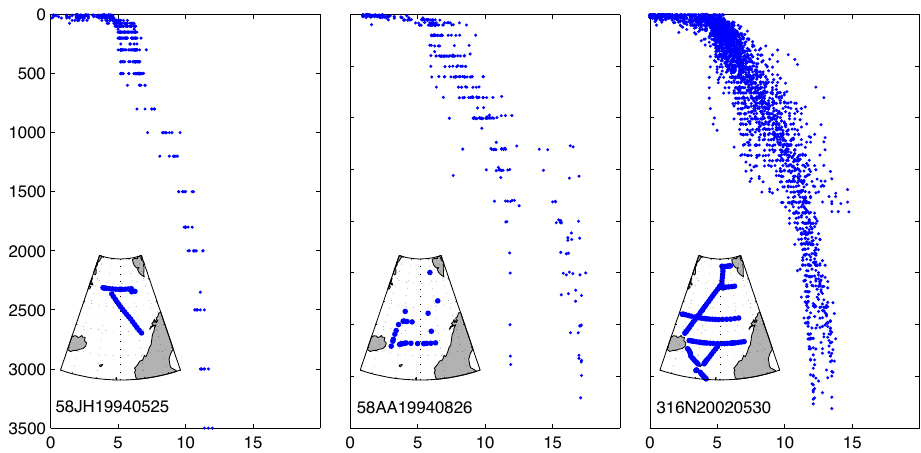
Figure 6. Silicate profiles from 58AA19940826 and two other cruises. the phosphate data of 58JH19920712 which appear low, this cruise took place over the Greenland Scotland Ridge area and can not be expected to be consistent with the others which were located mainly in the Greenland Sea and the Norwe- gian Sea, and has been labelled are “NC”. The greater hy- drographic variability in this region leads to di ffi culties in the evaluation of adjustments but nevertheless the “NC” data may well be of good quality. The data are hence included in the CARINA data